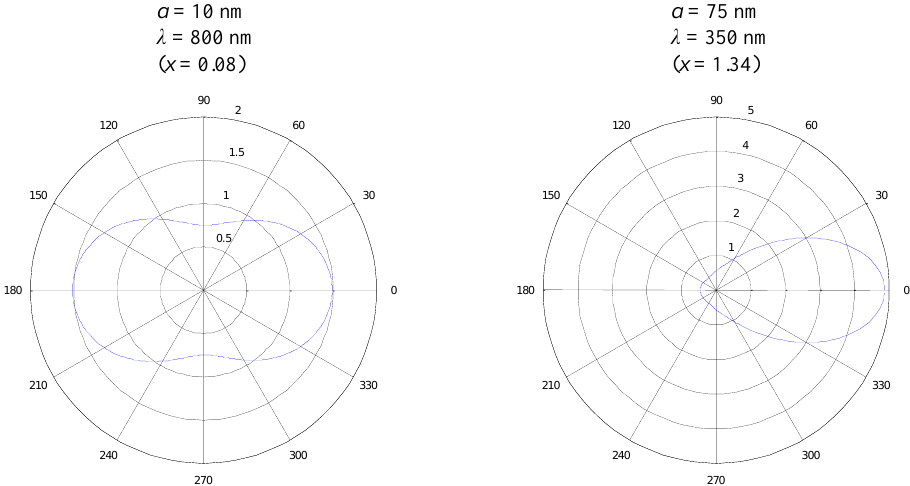
Figure 11. The scattering phase function for spherical particles is, besides material properties, a function of particle size a and wavelength λ of the incident light (irradiation from the left side of the